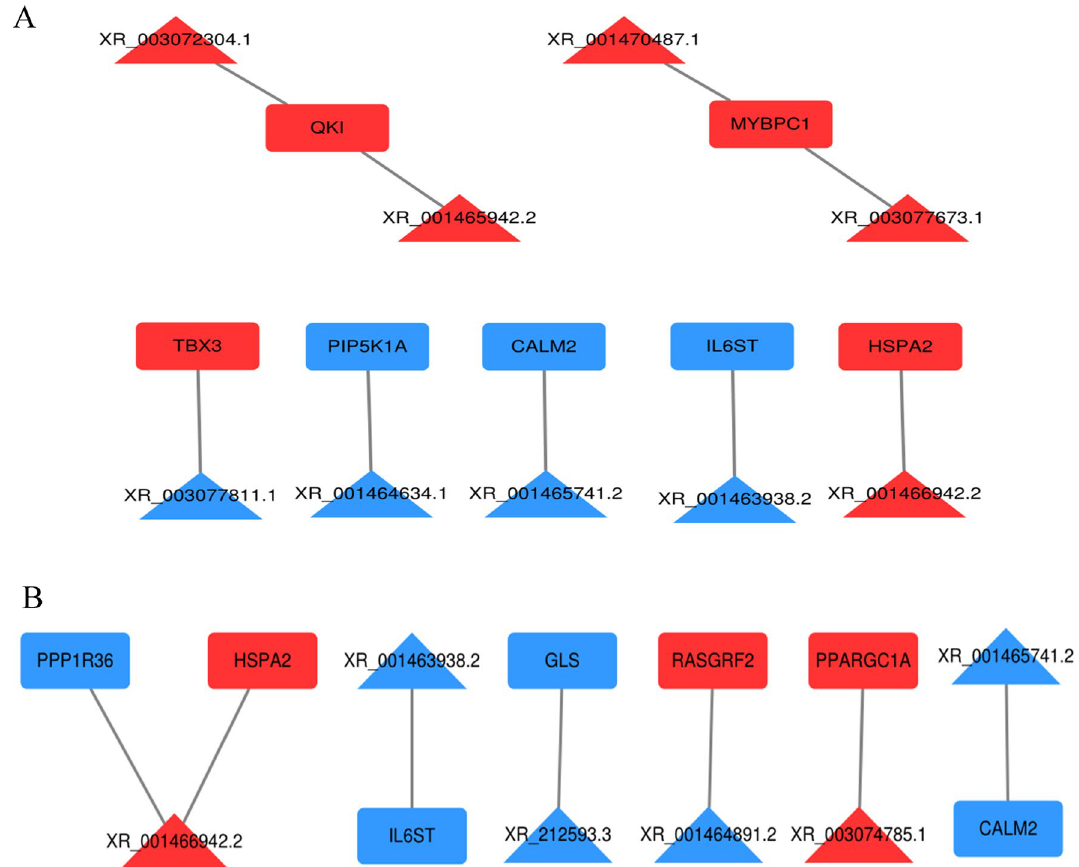
Figure 6. lncRNA-mRNA interactions for the selected cis-target DE genes. ( A ) lncRNA-mRNA interactions related to the GO terms. ( B ) lncRNA-mRNA interactions related to the KEGG signaling pathways. Genes are shown in rectangles, and lncRNAs are shown in triangles. RNA exhibiting upregulation is shown in red, whereas RNA exhibiting downregulation is shown in